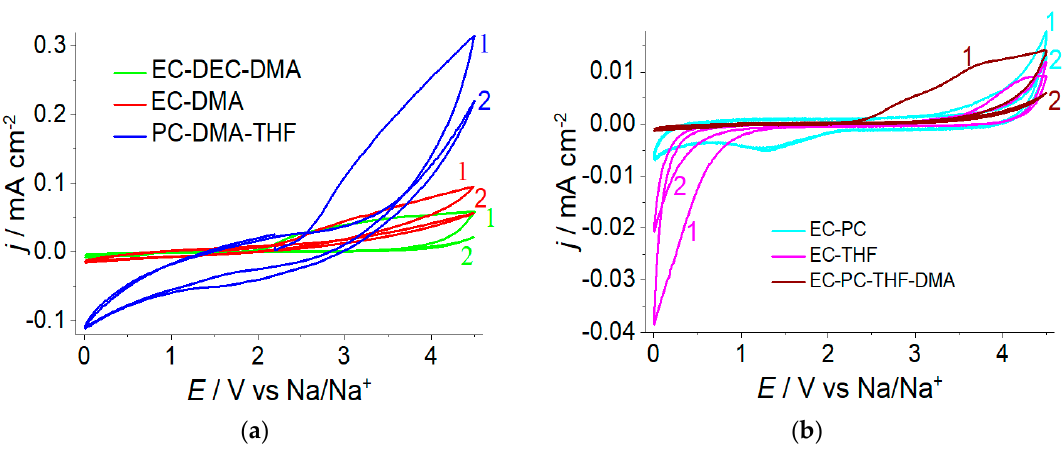
Figure 1. CVs at aluminum electrode in 1 M NaClO 4 in mixtures of solvents: ( a ) EC-DEC-DMA, EC-DMA, PC-DMA-THF and ( b ) EC-PC, EC-THF, EC-PC-THF-DMA at scan rate 10 mV s − 1 . Solvents compositions and cycle numbers are shown at the figures.